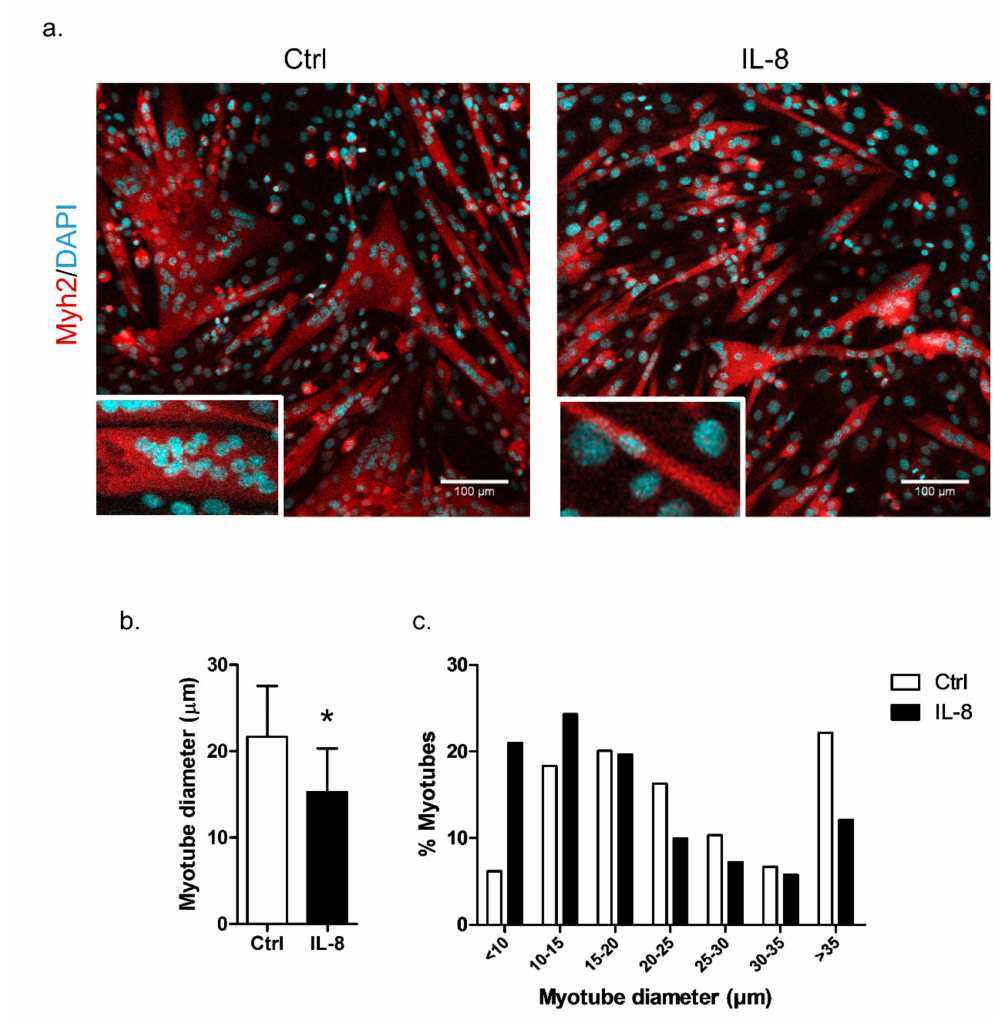
Figure 6. IL-8 (interleukin-8) induces atrophy in C2C12 myotubes. ( a ) Immunofluorescence of C2C12 myotubes treated with recombinant IL-8 (100 ng / mL for 24 h) immunostained for Myh2 (myosin heavy chain 2) (red) and the nuclei were counterstained with DAPI (4 (cid:48) ,6-Diamidine-2 (cid:48) -phenylindole dihydrochloride). White rectangles represent a myotube bigger than 35 µ m (Ctrl) or smaller than 10 µ m (IL-8). Scale bars, 100 µ m. ( b ) Myotube diameter ( µ m) quantification using ImageJ software (ImageJ, WI, USA). ( c ) Determination of the frequency of myotubes according to the diameter classes. The data represent the mean ± standard deviation from three independent experiments. The statistical significance was analyzed using the Student’s t -test. * p -value < 0.05. Ctrl: control myotubes; IL-8: myotubes treated with recombinant interleukin